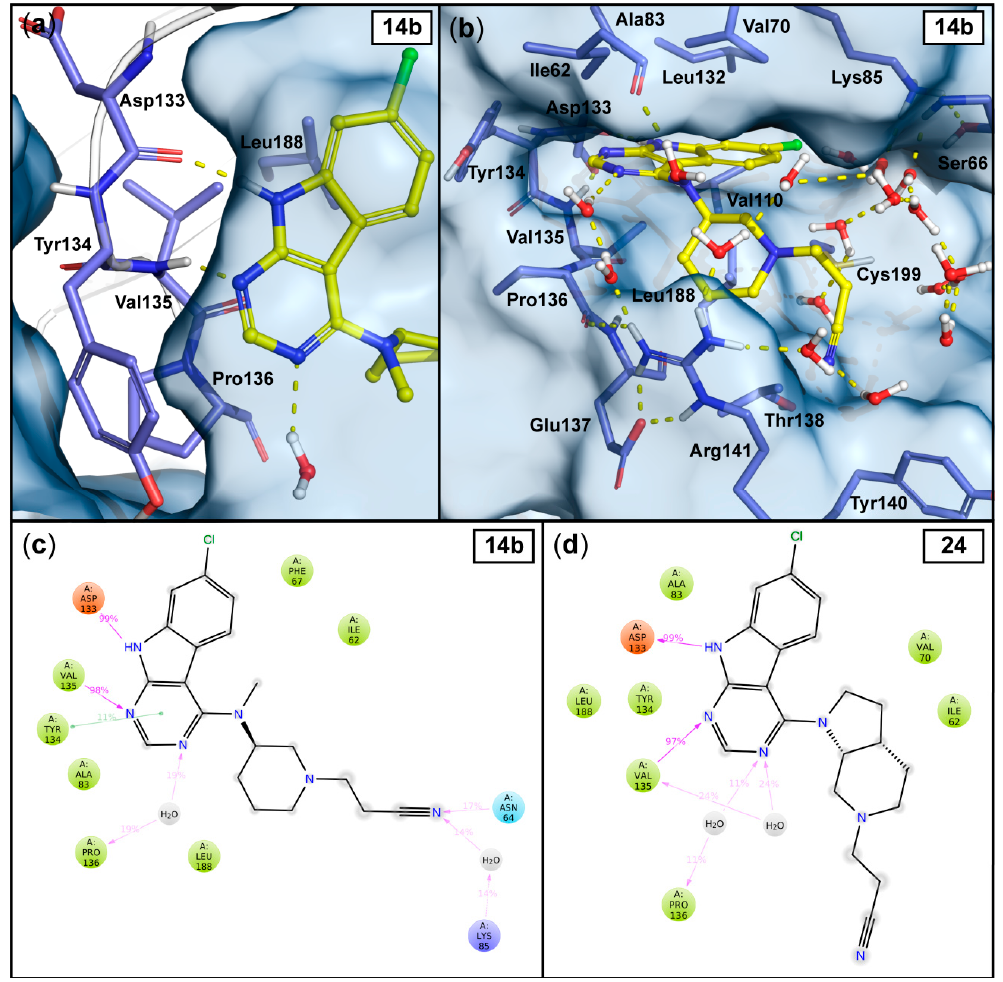
Figure 2. Observed interactions in the 1 µs MD simulations with the most potent compounds 14b and 24 . The output conformation of compound 14b (at 1000 ns) illustrates the stable hinge interactions with the Asp133 and Val135 and to the solvent (similar in 24 ) ( a ), as well as the solvent exposure of the cyanoethyl moiety ( b ). Hydrogen bonds are depicted as yellow dashed lines and the water molecules within 4Å from the ligand are shown. The simulation interaction frequencies of compound 14b ( c ) and compound 24 ( d ) were analyzed using the stabilized part of the simulations: 50–1000 ns and 30–1000 ns for 14b and 24 , respectively (see Figure 3c–d). Interactions that appeared with more than 10% frequency are shown; hydrogen bonds are depicted as purple arrows, π – π interactions are depicted as green lines.